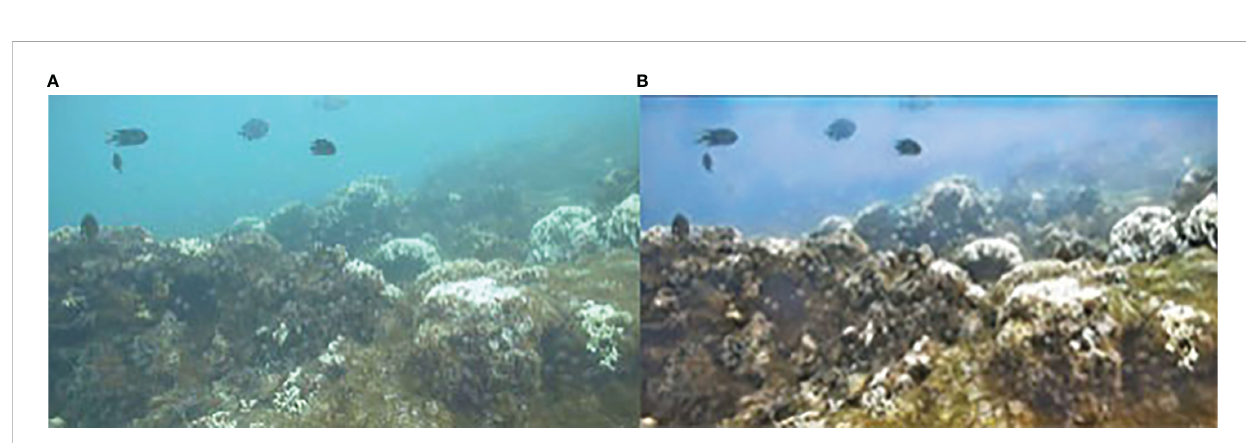
FIGURE 8 The enhancement result from the phenomenon of color bands. (A) The origin picture. (B) The enhancement picture with color